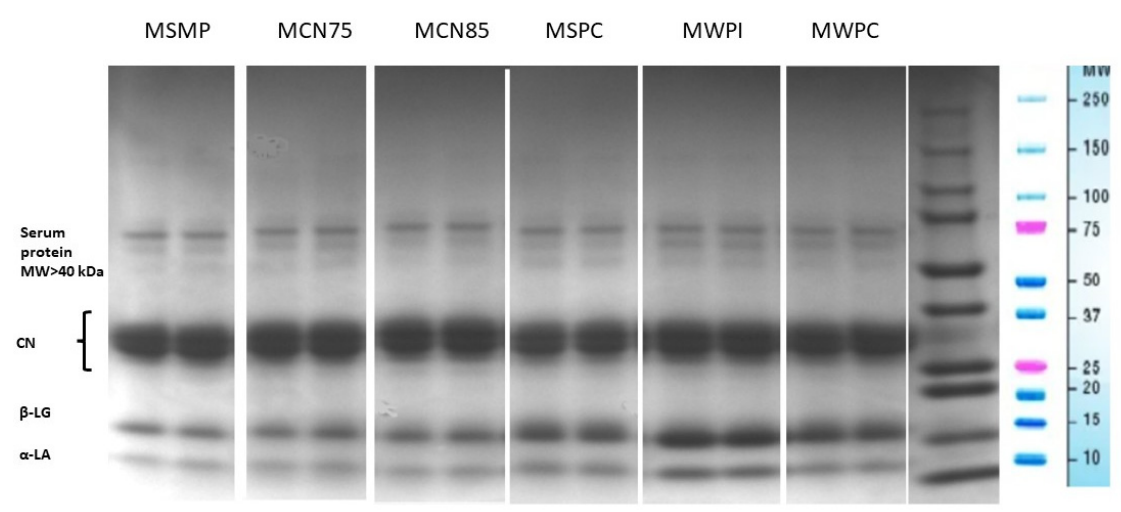
Figure 2. SDS-PAGE electrophoretogram of milk samples. MSMP—milk with skim milk powder, control sample; MCN75—milk with micellar casein concentrate with 75% protein content; MCN85—milk with micellar casein concentrate with 85% protein content; MSPC—milk with serum protein; MWPI—milk with whey protein isolate; MWPC—milk with whey protein concentrate.